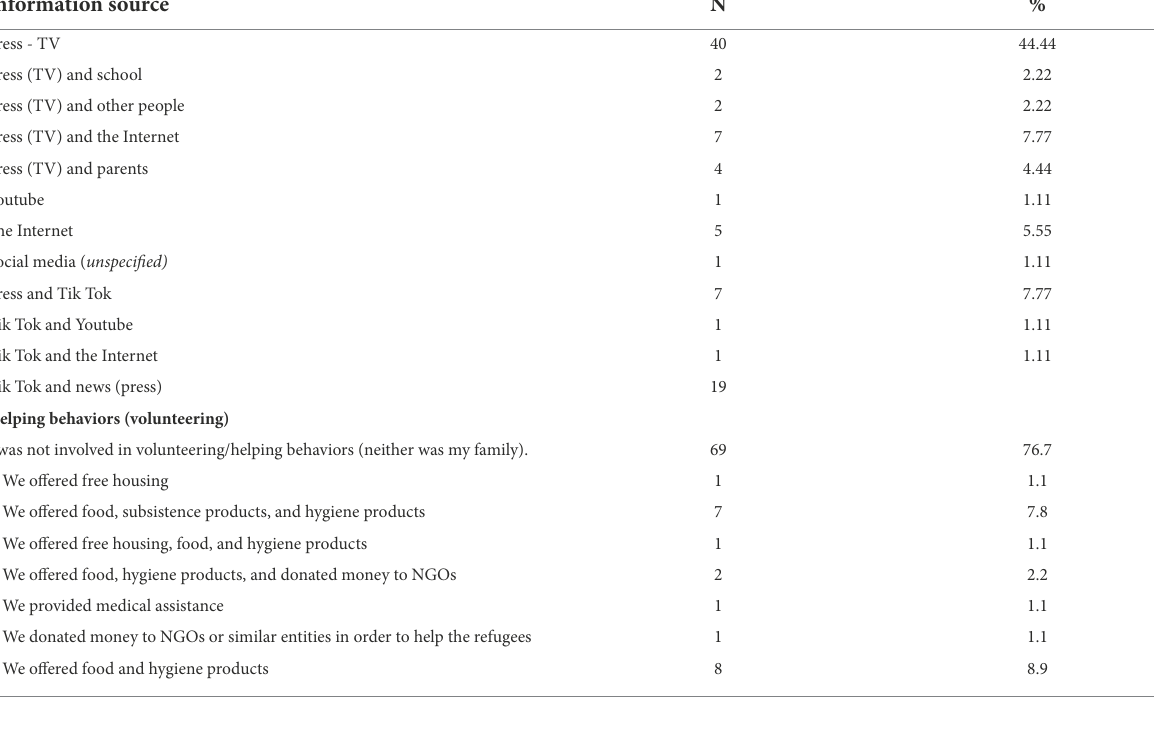
TABLE 2 Primary information sources regarding the conflict in Ukraine and volenteering